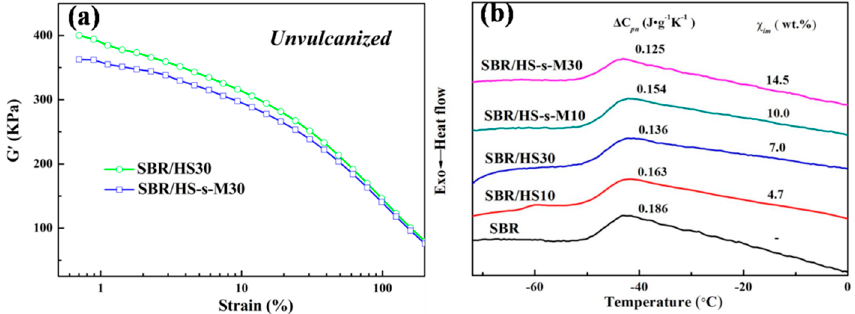
Figure 8. Dependence of the storage modulus (G’) of unvulcanized SBR compounds with 30 phr filler on strains (a) , DSC curves and weight fraction of immobilized rubber layer ( χ im ) of SBR composites (b) .